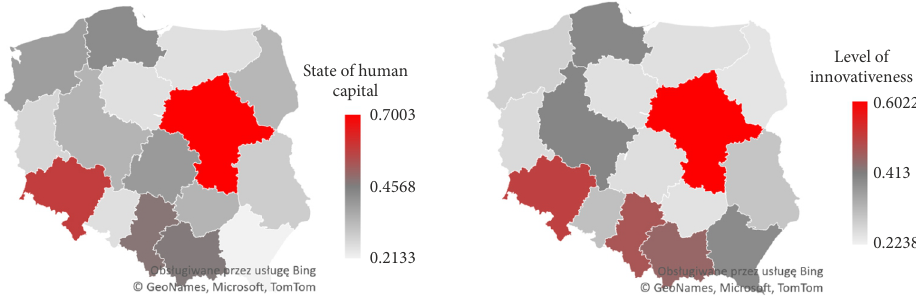
Figure 5. Average state of human capital and innovativeness in the years 2004–2018 on the current map of Poland (source: own